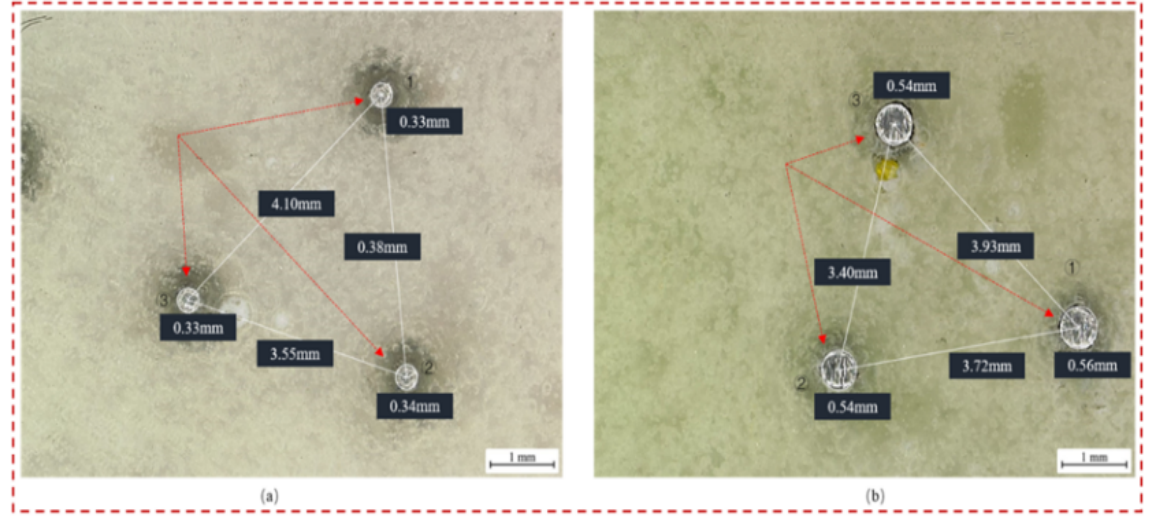
Figure 9. 2D morphology of diamond before and after dressing. ( a ) Appearance before trimming. ( b ) Appearance after trimming.